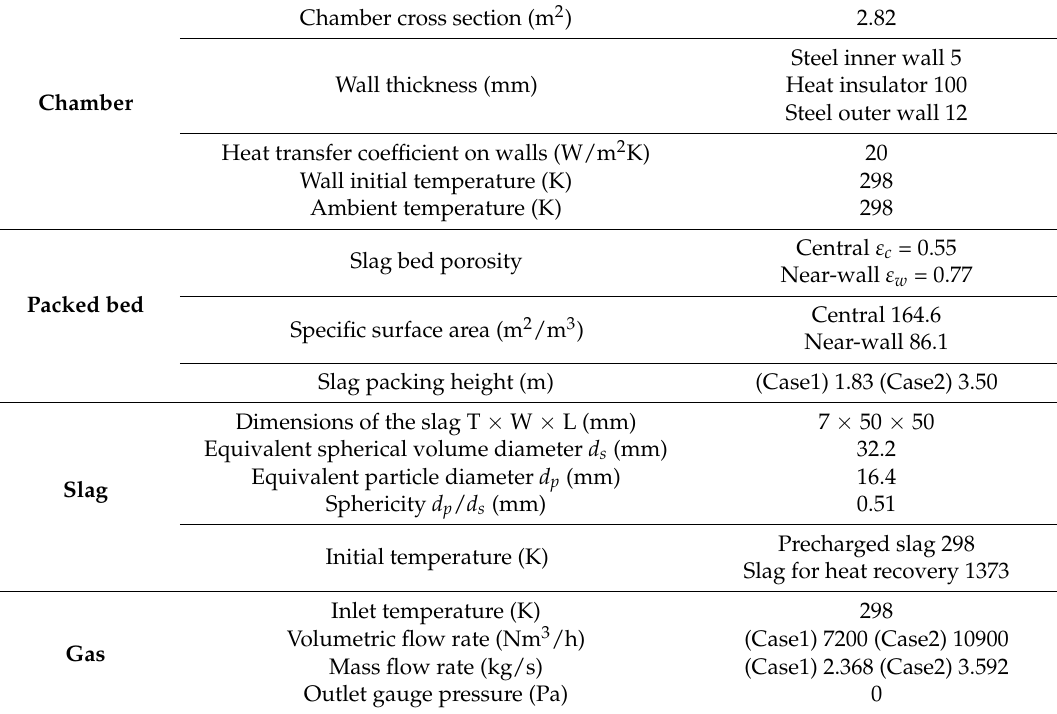
Table 5. Calculation conditions for pilot-scale CFD simulations (field and boundary conditions).